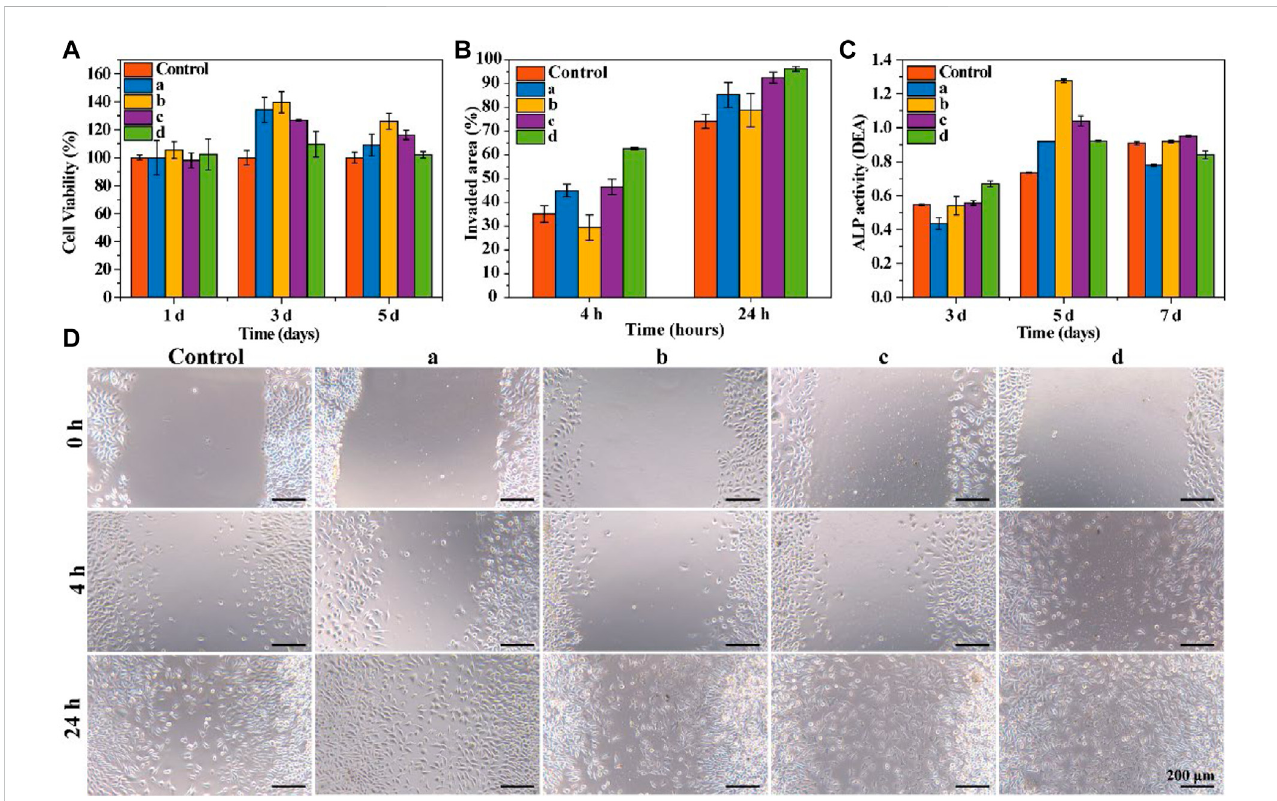
FIGURE 3 In vitro cytotoxicity and functional evaluation. (A) Cell viability of rBMSCs co-cultured with bone waxes over 7 days. (B) Quantitative analysis of scratch area at 4 h and 24 h (C) ALP activity assay of rBMSCs cultured with bone waxes at different timepoints. (D) Representative photographs of the migration of HUVECs treated with different bone waxes (a, b, c, and